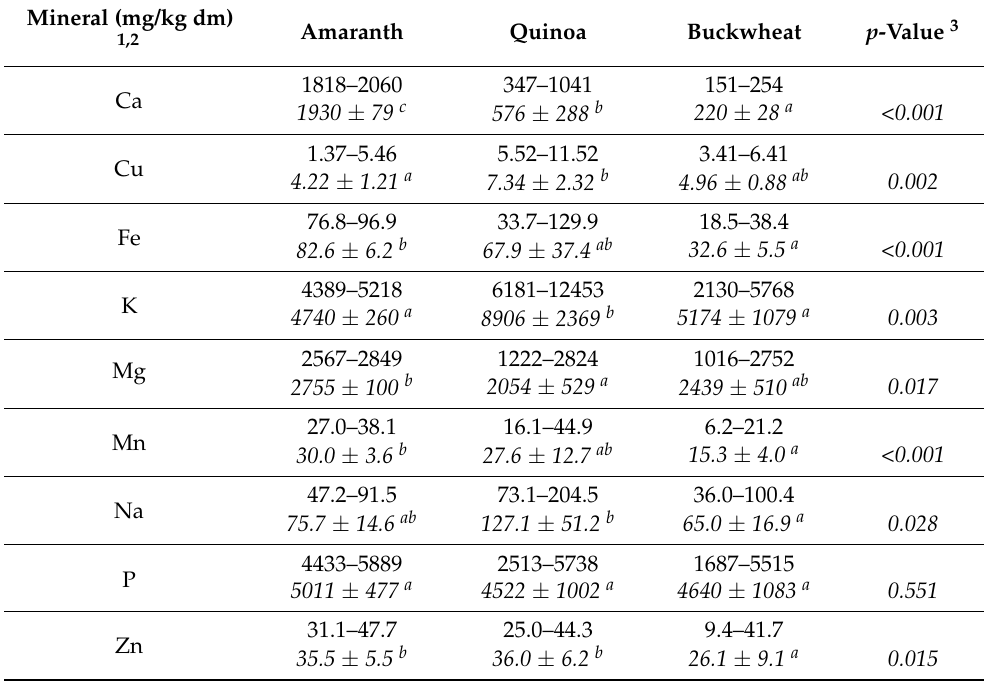
Table 5. Mineral composition of amaranth ( n = 8), quinoa ( n = 7) and buckwheat ( n = 10) whole- meal